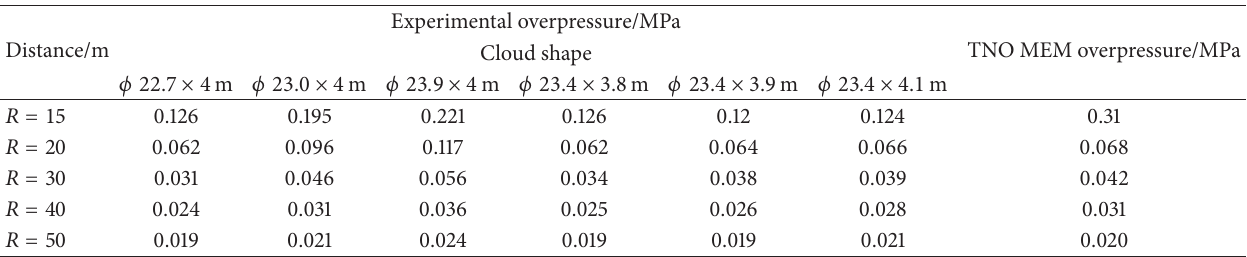
Table 3: Comparative experimental and theoretical overpressure of cloud detonation for different sizes